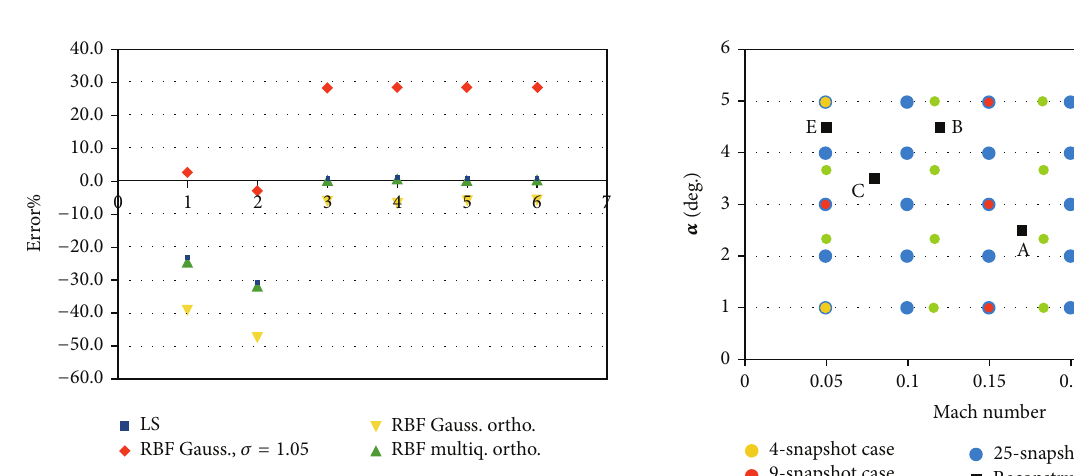
Figure 11: NACA 0012 airfoil. Errors for different response surfaces ( 𝑥 = 1 : error on the maximum value of the pressure field, 𝑥 = 2 : error on the minimum value of the pressure field, 𝑥 = 3 and 4: errorsonmaximumandminimumvaluesofthe 𝑥 -componentofthe velocity field, and 𝑥 = 5 and 6: errors on maximum and minimum values of the 𝑦 -component of the velocity field).